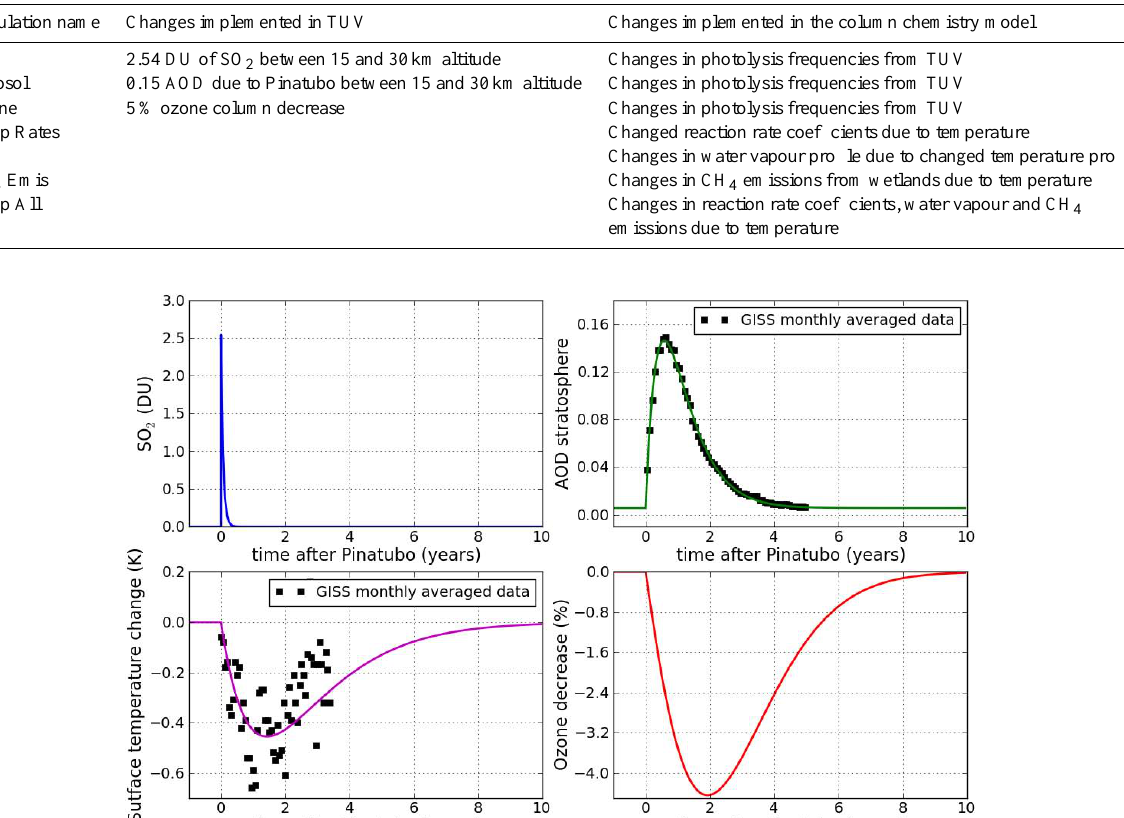
Table 2. Setup of the Pinatubo simulations. AOD = aerosol optical depth; DU=Dobson Unit.